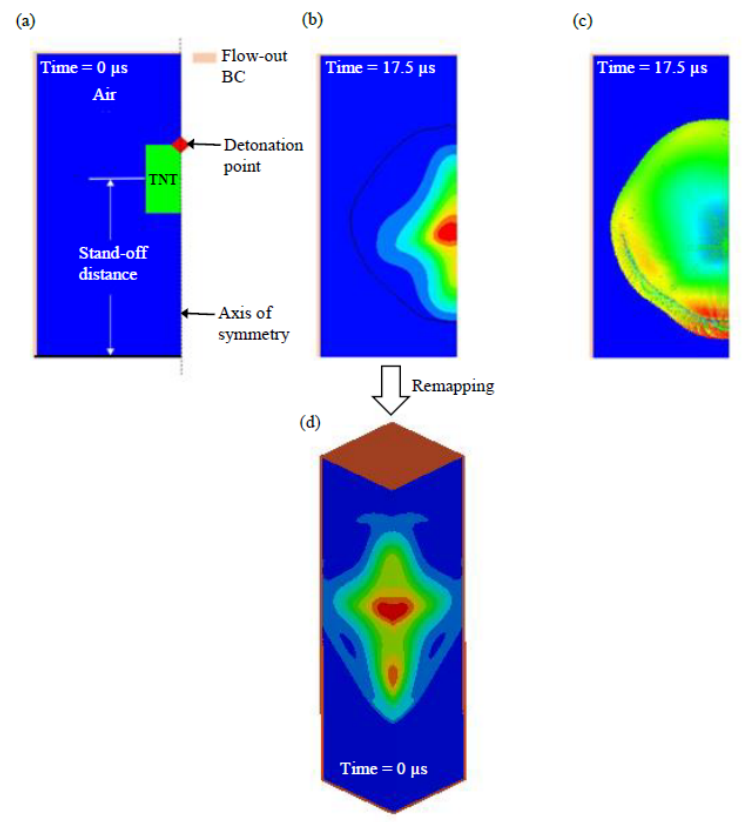
Figure 2. Remapping blast pressure from a 2D model to a 3D model. ( a ) The 2D model before detonation. ( b ) The pressure contour of the 2D model before striking the target. ( c ) The pressure vectors of the 2D model before remapping. ( d ) The pressure contour of the 3D model after remapping just before hitting the structure.